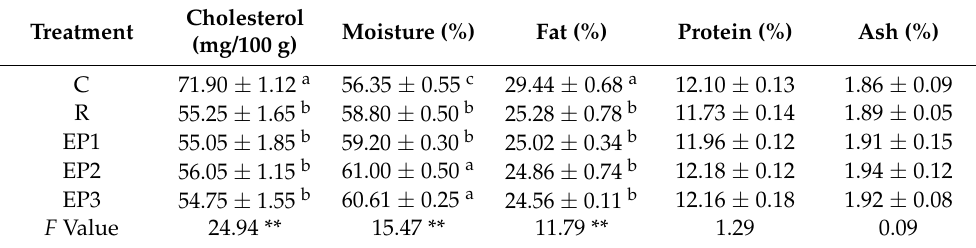
Table 2. Proximate composition of pork sausages. Cholesterol Treatment (mg/100